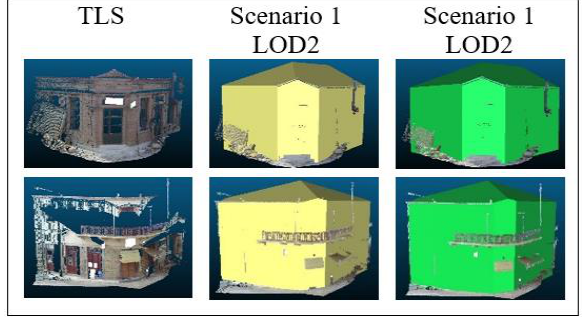
Figure 11. Example of visual inspection between two LOD2